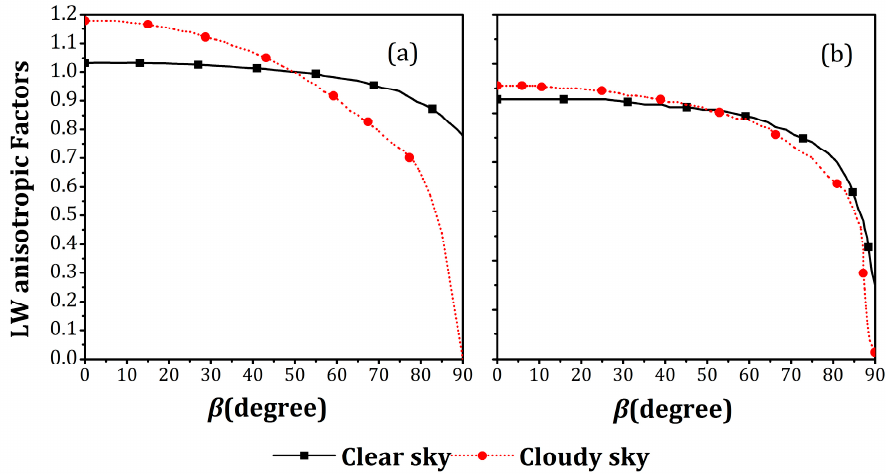
Figure 6. Earth TOA LW anisotropic factors for ( a ) the land, ocean, and desert surface types; and ( b ) the snow surface type, as a function of the MERO viewing zenith angle β .